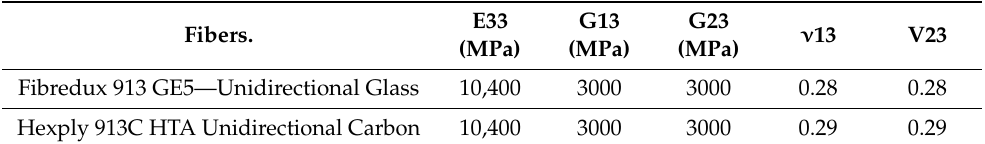
Table 3. Out-of-plane material properties of unidirectional layers in sandwich faces under compression.